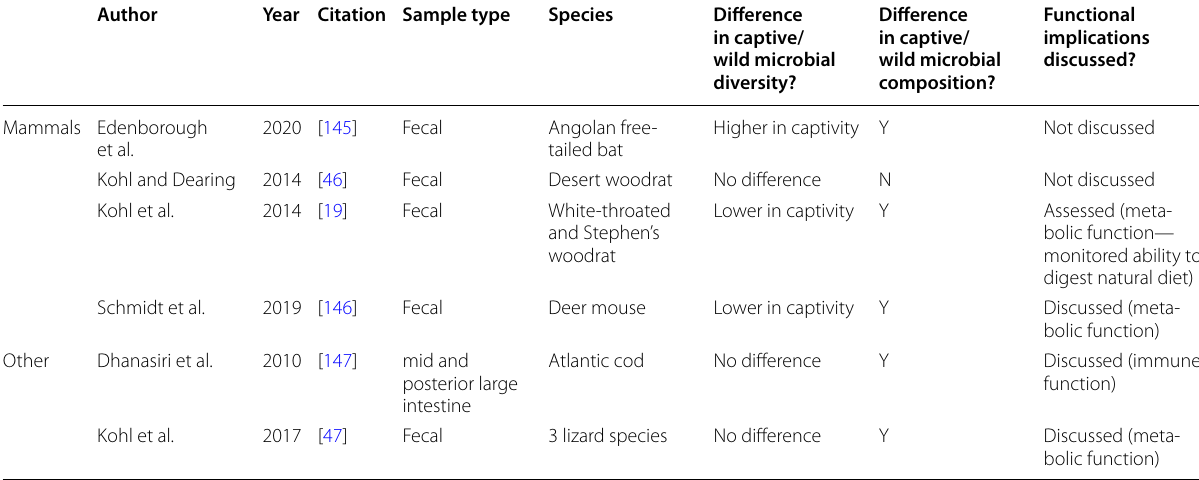
Included is whether the paper reported an increase or decrease in microbial diversity and microbial composition, as well as whether functional implications of these differences were discussed or assessed. Papers were found with a directed review of existing literature including a Google Scholar search and consulting references cited in each paper collected. We retained only those studies which include a wild population brought into captivity within a single